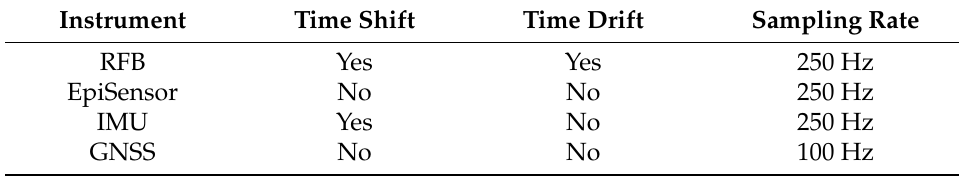
Figure A1. The figure shows the time shift and drift applied to the RFB and IMU data sets. The experiments 3,4,5,10,11,12 do not have linear time shifts, therefore the corrections still do not allow a good comparison. TLRL: 1,2,7,8; TLRS: 3,4,9,10; TSRS: 5,6,11,12. Table A3. Instrument information.